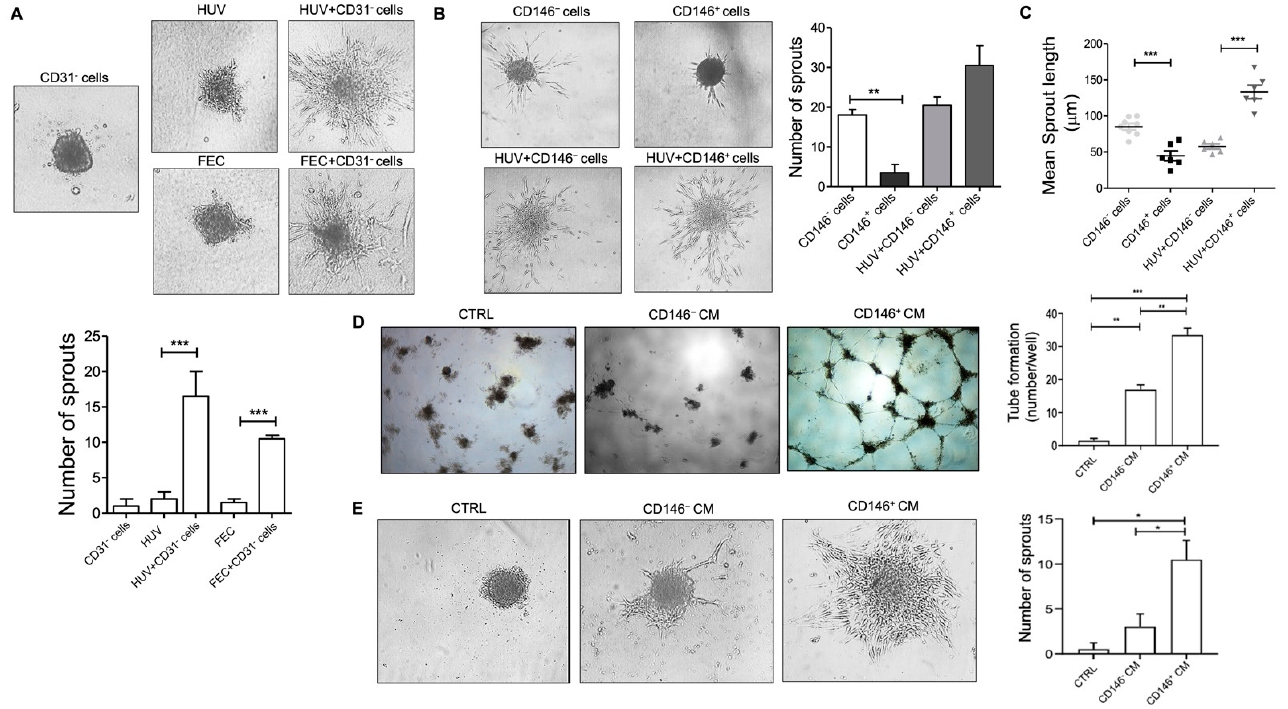
Figure 4. Sprout formation from ECs and PCs co-culture spheroids. ( A ) Representative images of sprout formation from ECs-only (HUVECs or CD31 + Fat ECs), and CD31 – PCs:ECs (1:5) co-culture spheroids embedded in type I collagen gel at 24 h (magnification, 20 × ). The quantitative graph shows sprout numbers formed from CD31 − PCs- or ECs-only (HUVECs or CD31 + fat ECs), compared to co-culture spheroids (mean ± SD, n = 3). ( B ) Sprout formation from CD146 − and CD146 + PCs-only, and PCs + ECs (HUVECs) co-culture spheroids in collagen after 24 h of embedding (magnification, 20 × ). The quantitative graph displays the number of sprouts at 24 h from PCs-only and PCs:ECs (1:5) co-culture spheroids (mean ± SD, n = 3). ( C ) The scatter plot displays the mean sprout length (in µ m) per spheroid at 24 h (mean ± SD, n ≤ 6). Images are representative of one out of three independent experiments with similar results performed in triplicates. ( D ) HUVECs were seeded on BME-coated plates and stimulated with CM from CD146 − and CD146 + pericytes in culture. Images were taken after 24 h of plating the assay (original magnification, 10 × ). HUVECs treated with EGM complete medium were used as a control. The number of cords was counted as a parameter for the quantification of tube formation. ( E ) The 3-D spheroids assay of HUVECs in the presence of CM from CD146 − and CD146 + cells. HUVECs treated with EGM complete medium were used as a control. Images were taken after 24 h at 10 × magnification. Images are representative of one out of two independent experiments with similar results performed in triplicates. Statistical analysis was performed by one way ANOVA and Bonferroni’s post-test; * p ≤ 0.05, ** p < 0.01, *** p < 0.001. HUV—human umbilical vein endothelial cells; FEC—endothelial cells from fat